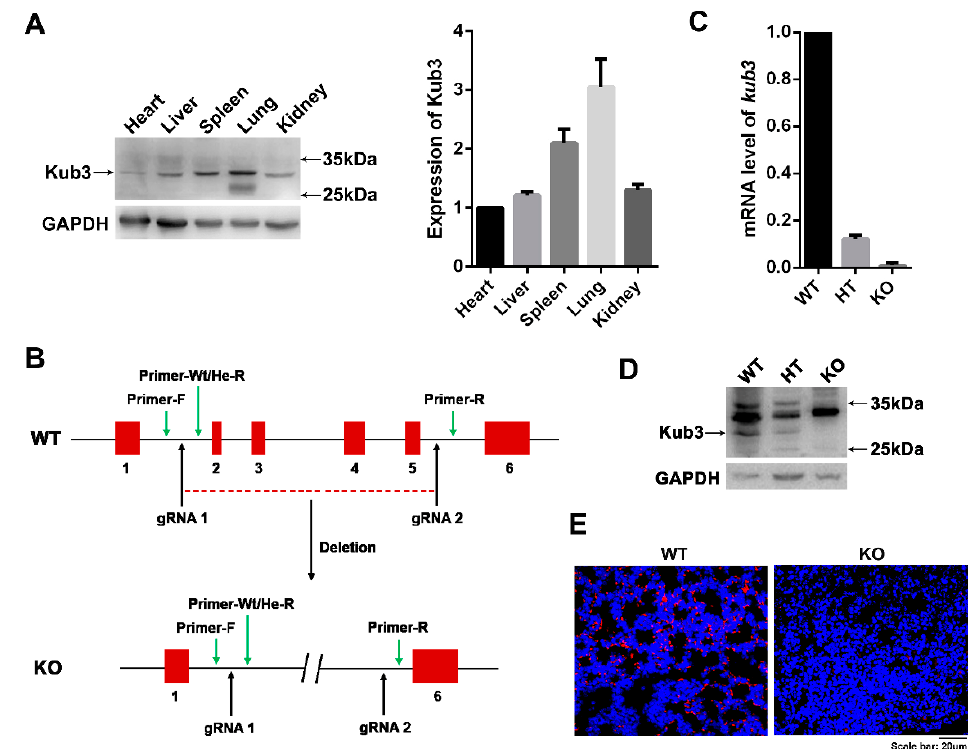
Figure 1. Kub3 gene knockout in mice results in perinatal or neonatal lethality. ( A ) Tissue distribution of Kub3 expression in adult mice examined by Western blot (WB). Total protein lysates were isolated from different organs of adult mice. Western blot was performed with antibodies against Kub3. GAPDH is the internal control. The ratios of Kub3 to GAPDH expression are represented by the graphs ( n = 3). ( B ) Schematic diagram depicting the deletion of exons 2-5 from the wild-type Kub3 gene and creating Kub3 knockout mice. Red squares represent the exons of Kub3 and blue arrows indicate the sites of the primers for genotype identification. ( C ) Quantitative RT-PCR analy- sis of Kub3 mRNA levels in E18.5 embryos. GAPDH was used as an internal control for